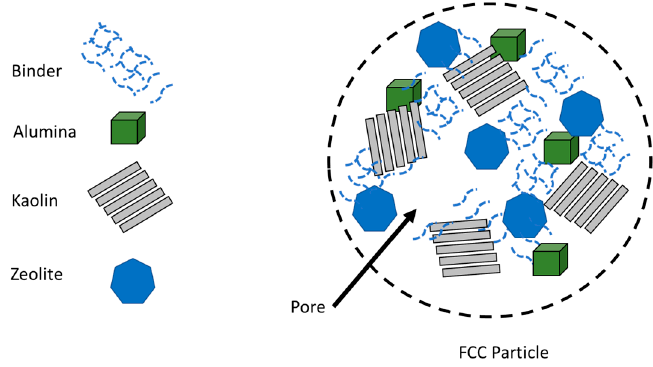
Figure 2. Typical chemical and structural composition of an FCC particle .